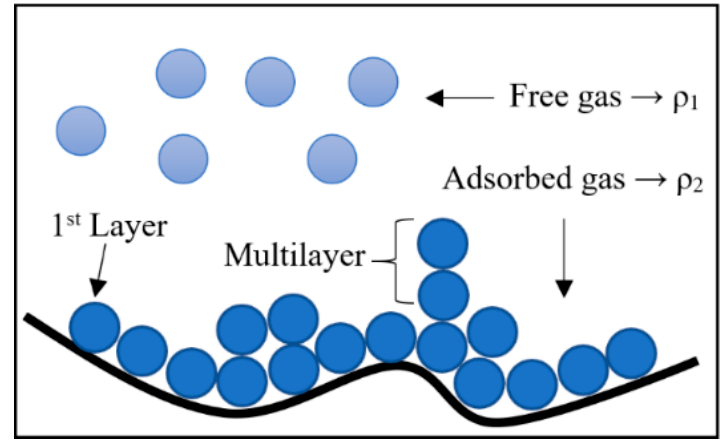
Figure 1. Physisorption process on solid surface.